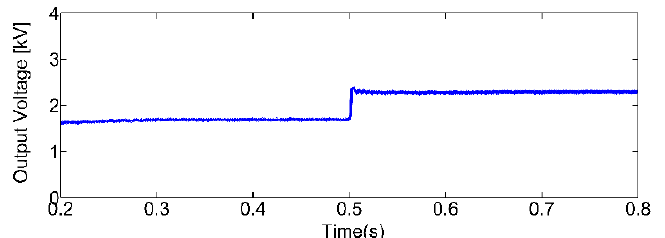
Figure 11. Comparison of the output voltages for different DC-DC MMC topologies when r = 0.5. ( a ) Output voltage of the DC-DC MMC without adopting the middle cells. ( b ) Output voltage of the proposed DC-DC MMC.